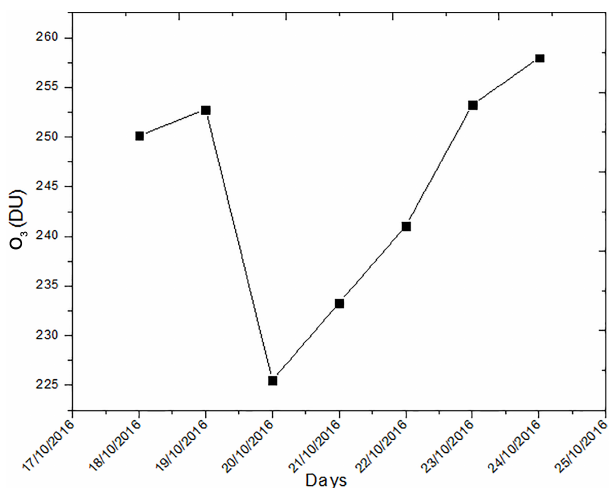
Figure 5. Total ozone column as measured by the Brewer Spec- trophotometer at the Southern Space Observatory (SSO/INPE), São Martinho da Serra/RS-Brazil from 18 to 24 October